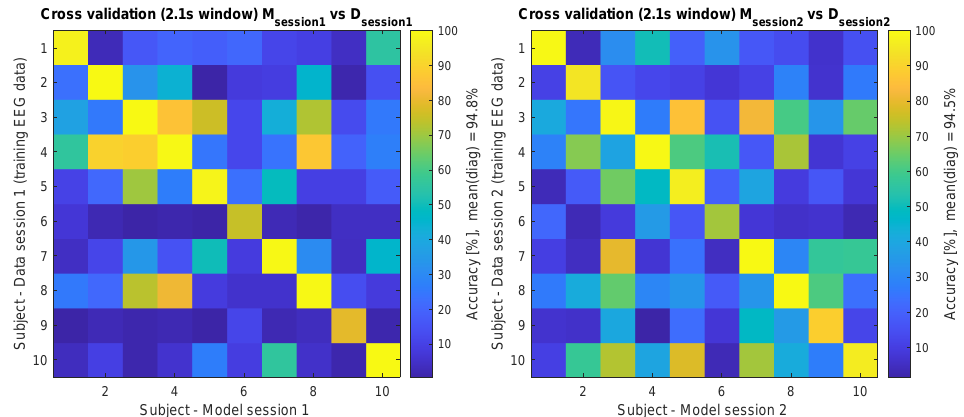
Figure 3. Cross-validation of the training EEG data (2.1 s). This figure shows the accuracy of M session1 Data session1 and M session2 Data session2 tested across all participants, where e.g., the model (M) from session 1 was used to classify the session 1 training EEG data ( left side), and model (M) from session 2 was used to classify the session 2 training EEG data ( right side).